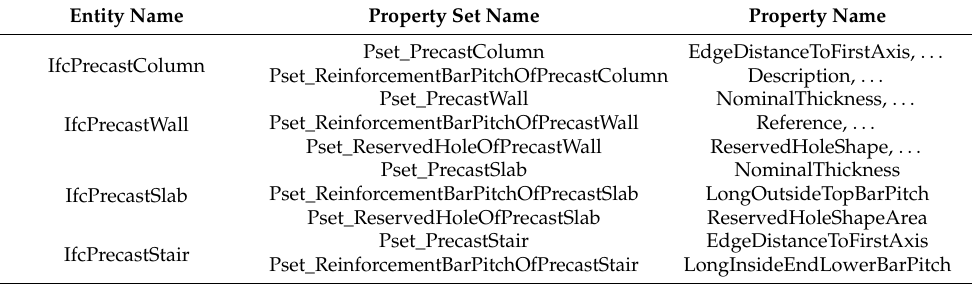
Table 6. Example of assembled model extended component entities and property sets.